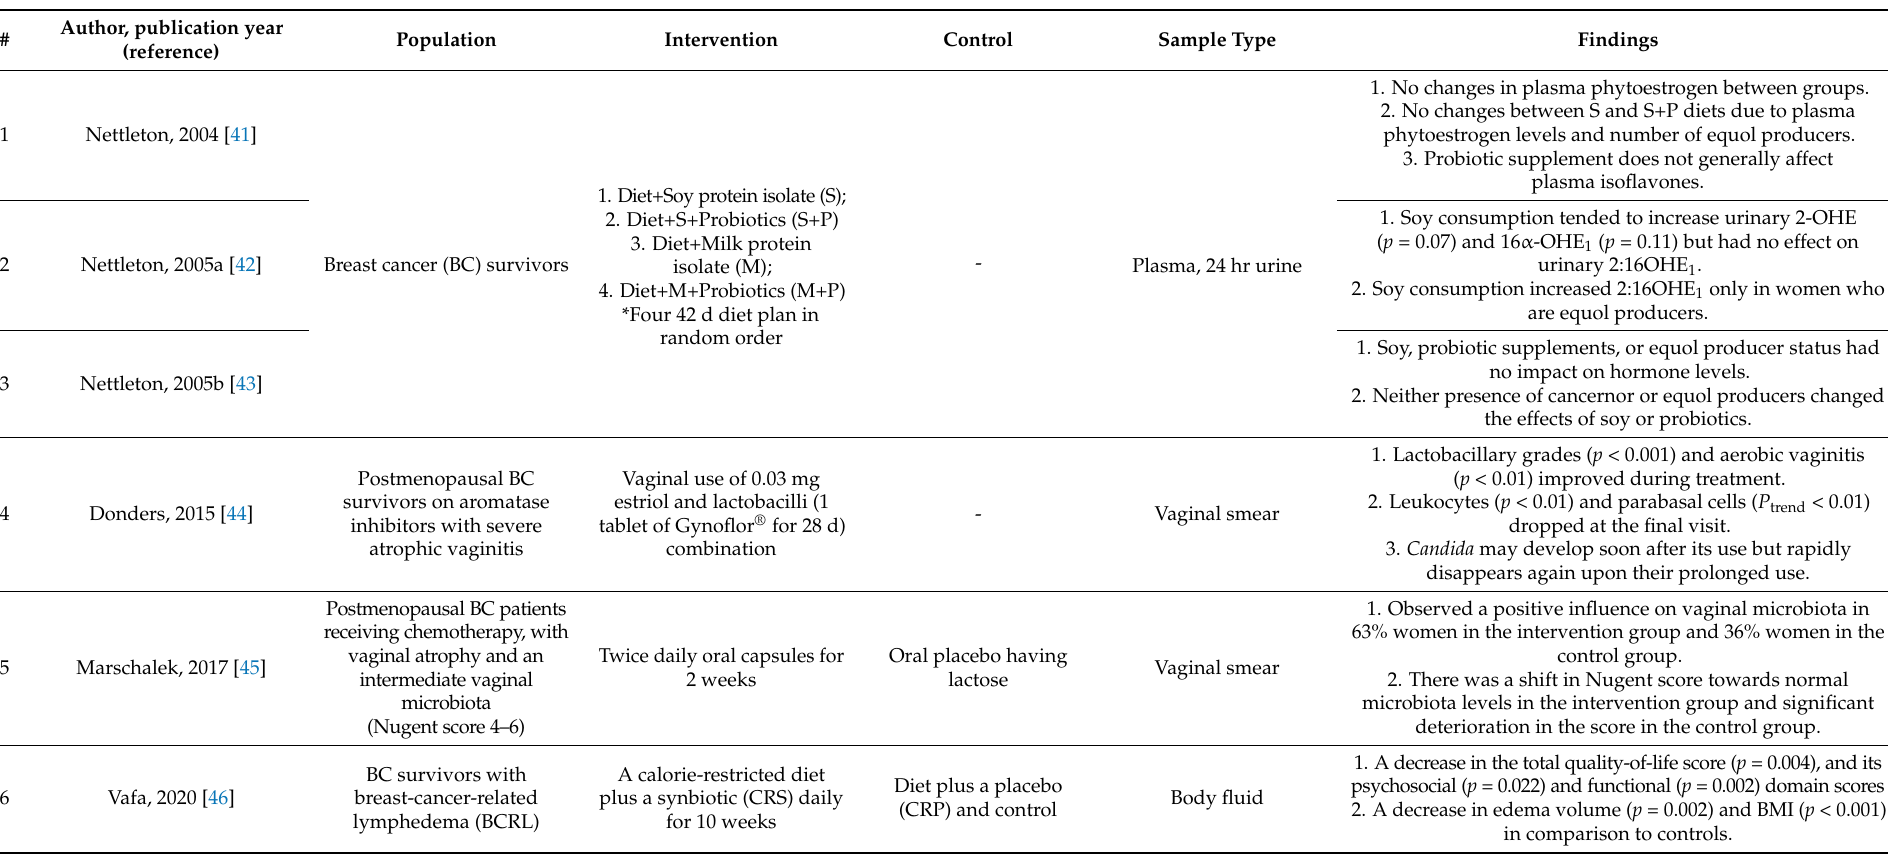
Table 3. Qualitative analysis for all the included studies amongst the identified